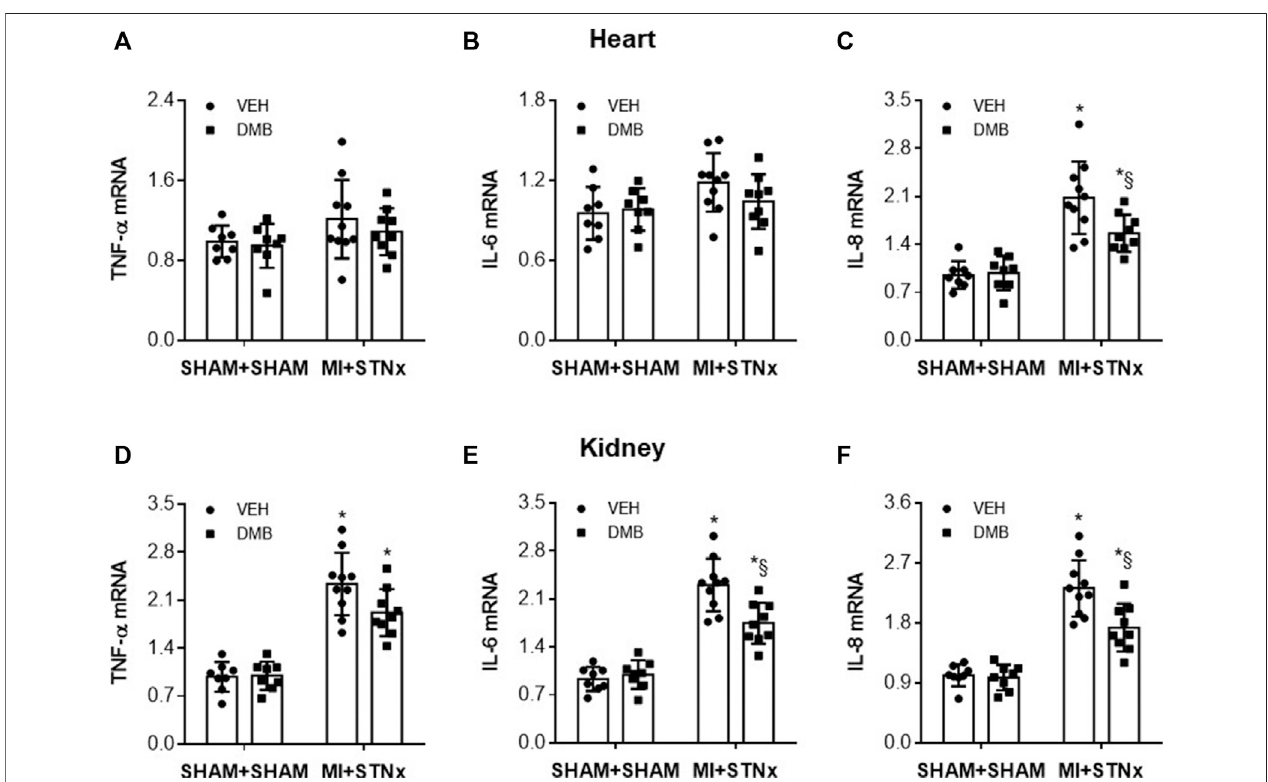
FIGURE 8 | Effects of CRS2 and DMB treatment on gene expression of pro-in fl ammatory cytokines tumor necrosis factor (TNF)- α (A) and (D) and interleukin (IL)- 6 (B) and (E) and IL-8 (C) and (F) in theheartand kidney, respectively.Dataare expressed as mean ± SE( n (cid:1) 8 – 10for each group). * p < 0.05 vs SHAM +SHAM +VEH; § p < 0.05, MI + STNx + DMB vs MI + STNx +